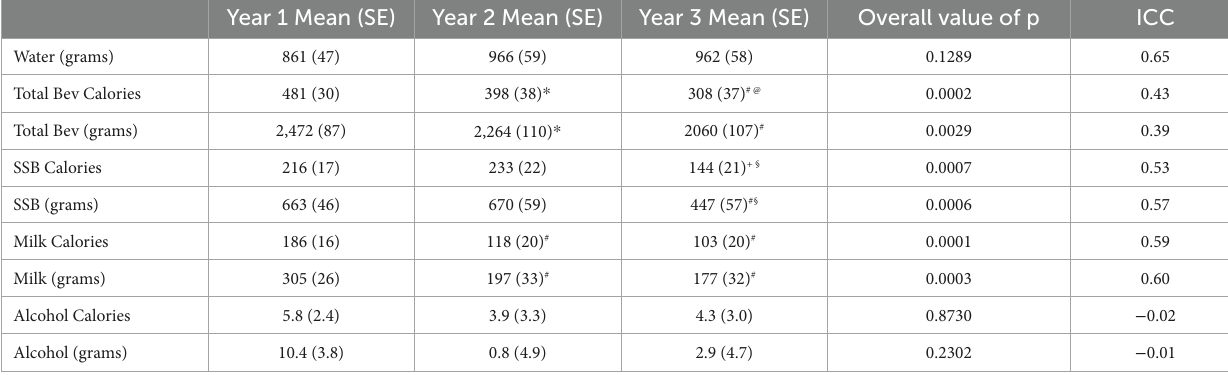
TABLE 4 Dietary changes related to beverages among cohort participants,